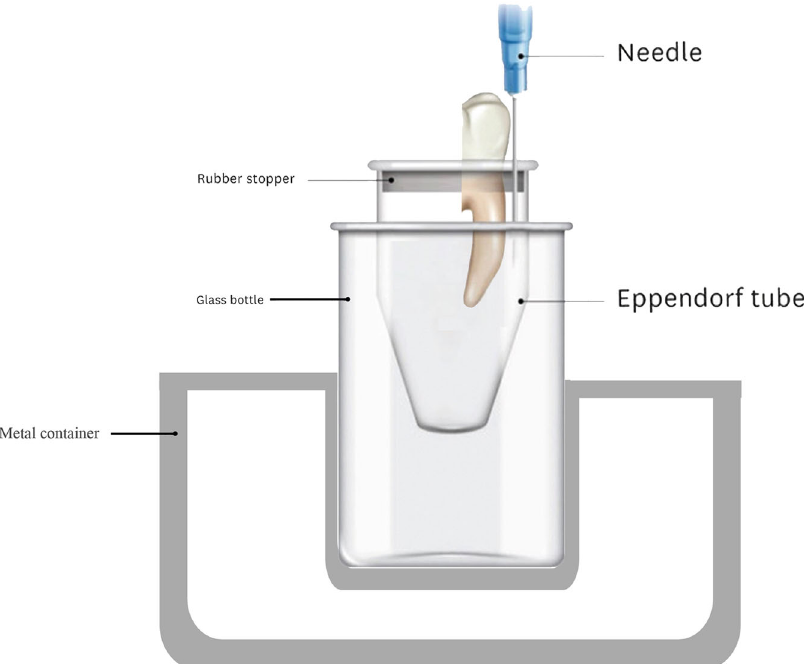
Fig. 1 Schematic representation of the debris collection test model. The mesial root was inserted into a hole made on the stopper of an empty eppendorf tube. To keep the air pressure inside and outside of the tubes balanced, a 27-gauge bent needle was inserted. The whole apparatus was concealed in a glass vial covered with adhesive plaster to prevent the operator from seeing through during the instrumentation process. The whole assembly was mounted in a metal